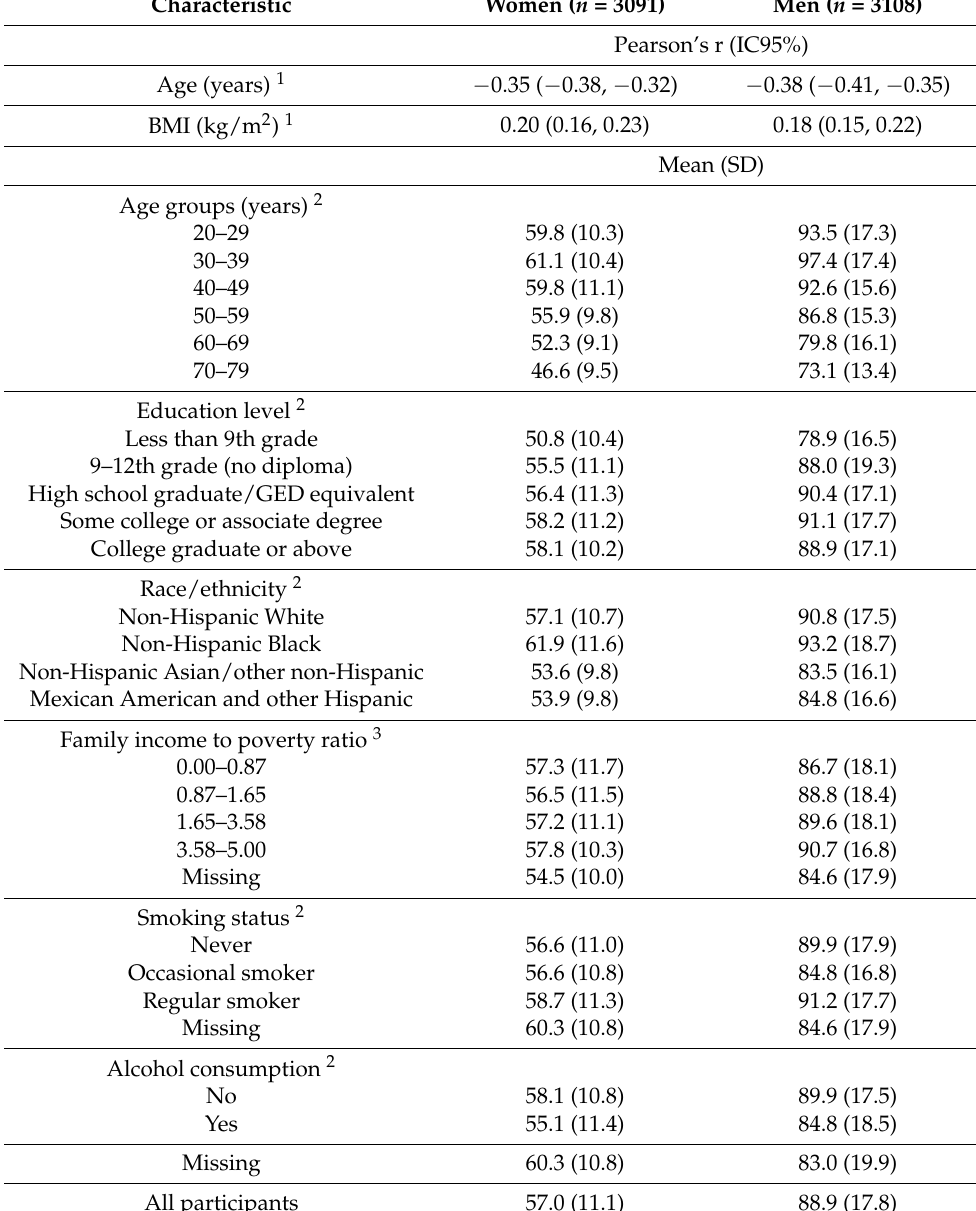
Table 3. Grip strength with respect to individual characteristics in women and men.